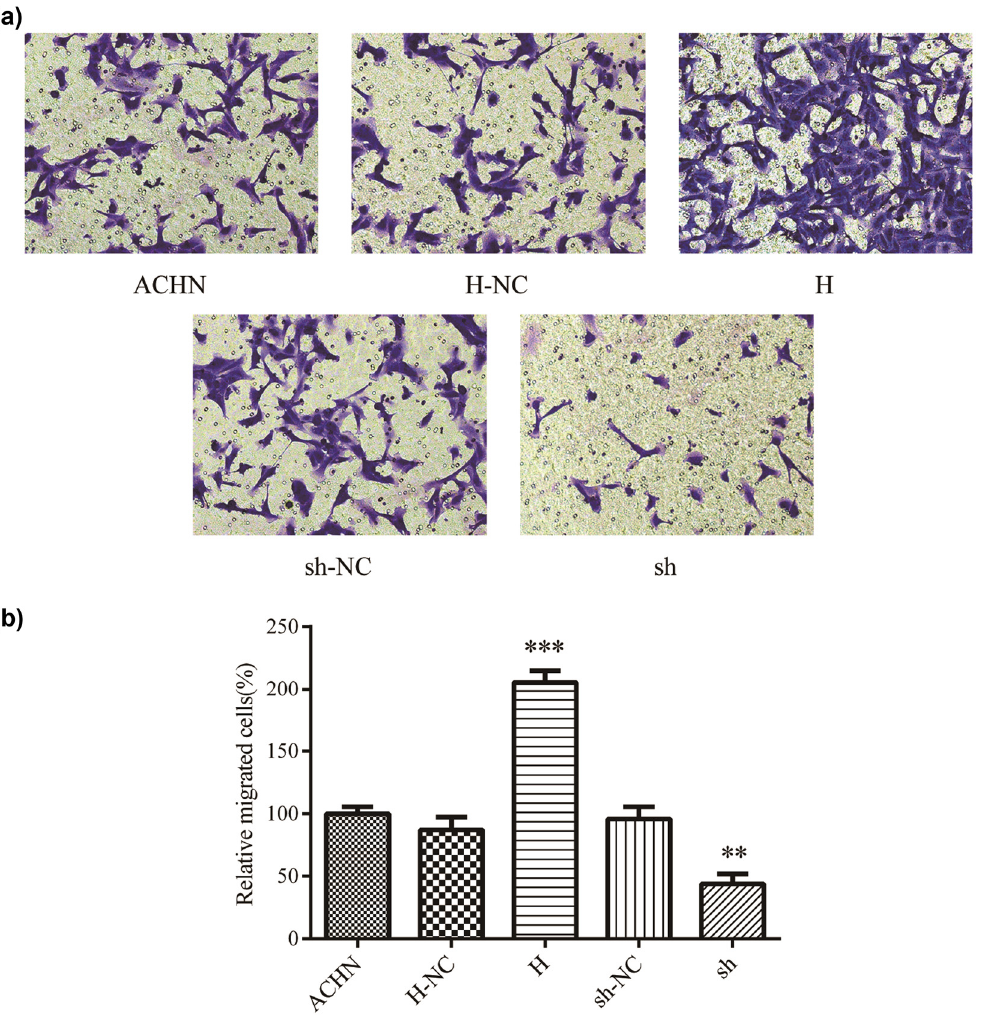
Figure 3: Trim24 promoted the migration of ACNH cells. ( a ) Transwell assay was performed to estimate the e ff ect of Trim24 on cell migration. Migrated cells were photographed ( 200 × magni fi cation ) after incubated in transwell chambers for 48 h. ( b ) Counting and analysis of migrated cell numbers. ** P < 0.01 and *** P <